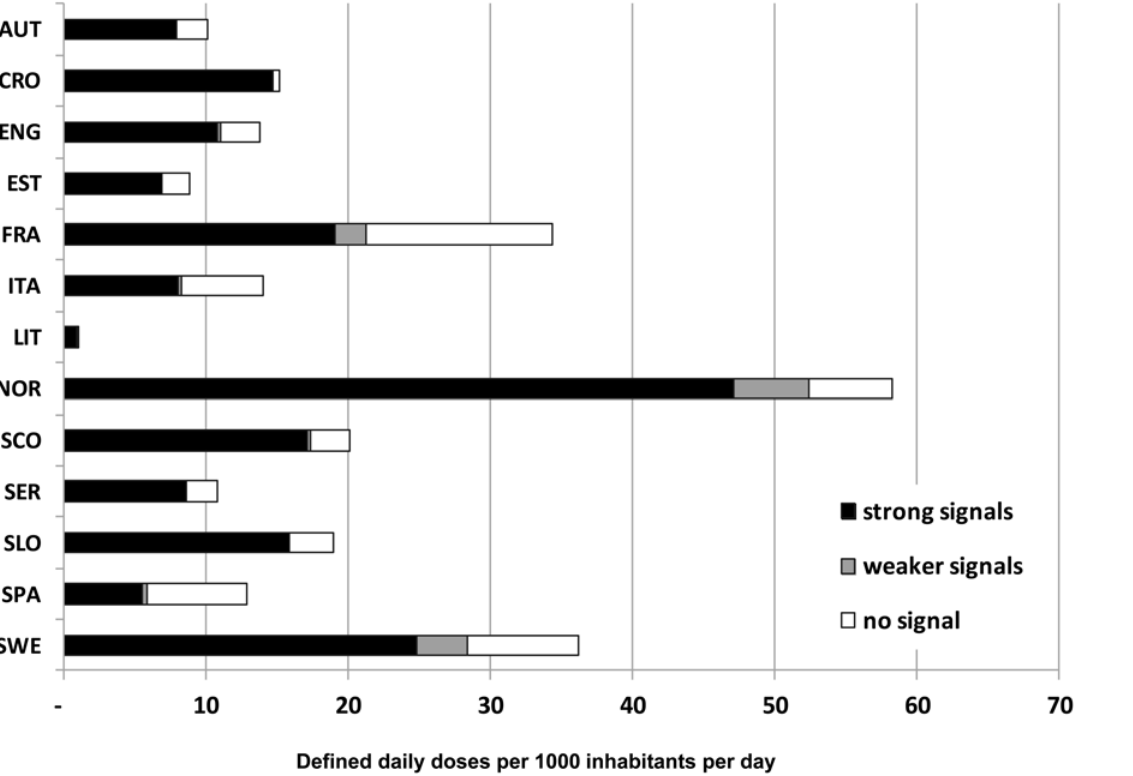
Fig 2. Antihistamine utilisation on the basis of pharmacovigilance